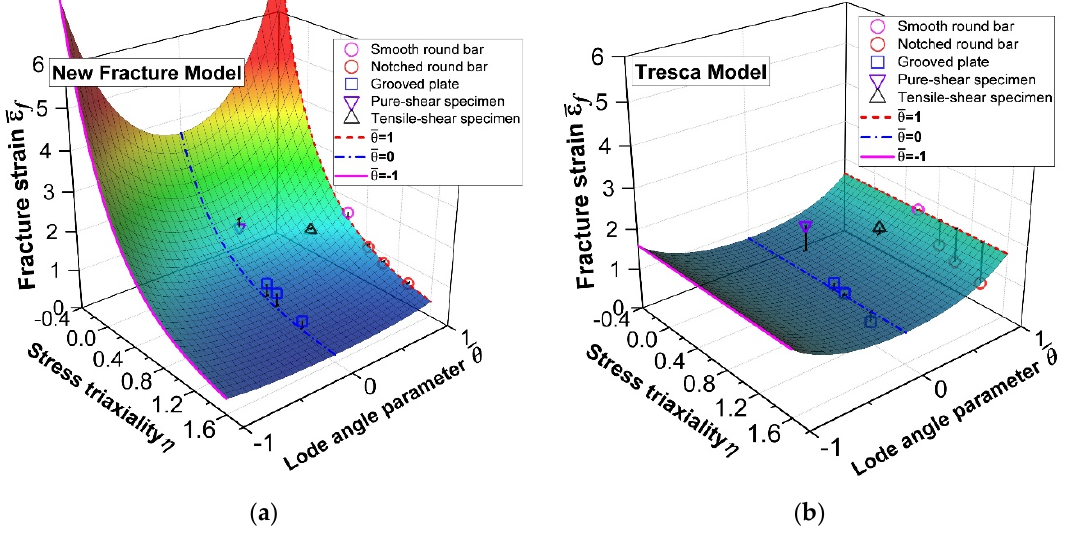
Figure 4. Fracture strain envelope of the Q460 structural steel predicted from: ( a ) the new fracture model; ( b ) the Tresca model.